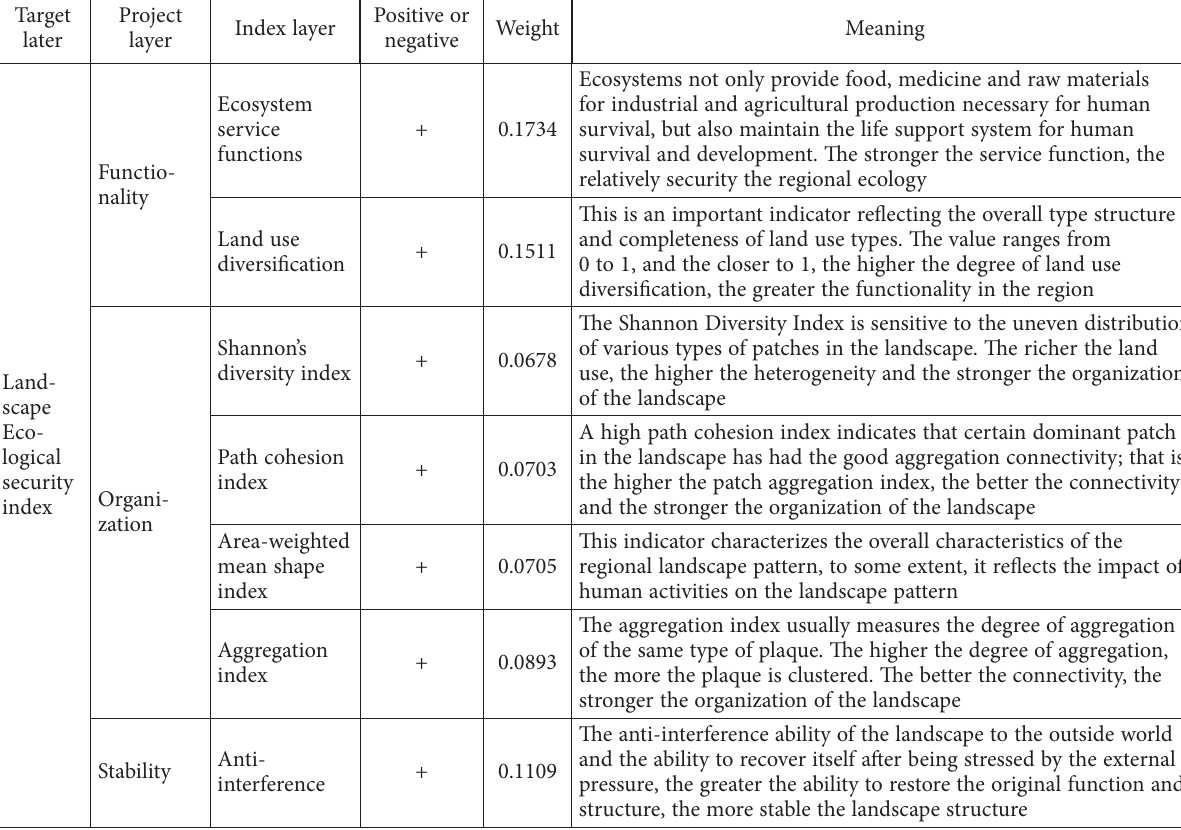
Table 1. Regional ecological security assessment system based on the functionality, organization and